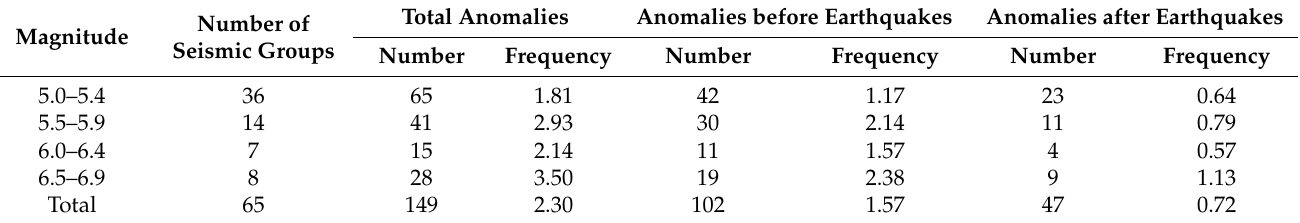
Table 2. Relationship between the earthquake magnitude and the number and frequency of Ne anomalies (from 30 d before to 10 d after the